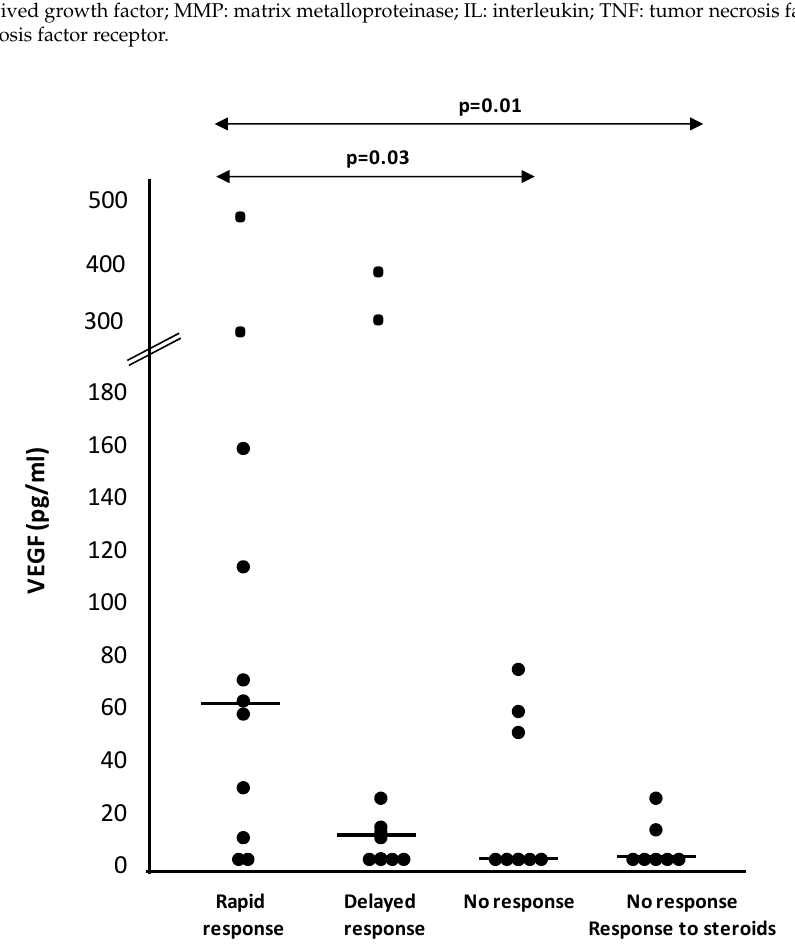
Figure 2. Correlation between aqueous and vitreous levels of VEGF. Levels of IL-1 β , IL-10, IL-12, EGF, TNF- α , and PDGF-AB/BB were found to be undetectable in most samples. Therefore, only PlGF, HGF, angiopoietin-2, PDF-AA, MMP-9, IL-6, IL-8, TNFR1 and TNFR2 were analyzed. Slow responders to anti-VEGF therapy showed higher levels of inflammatory